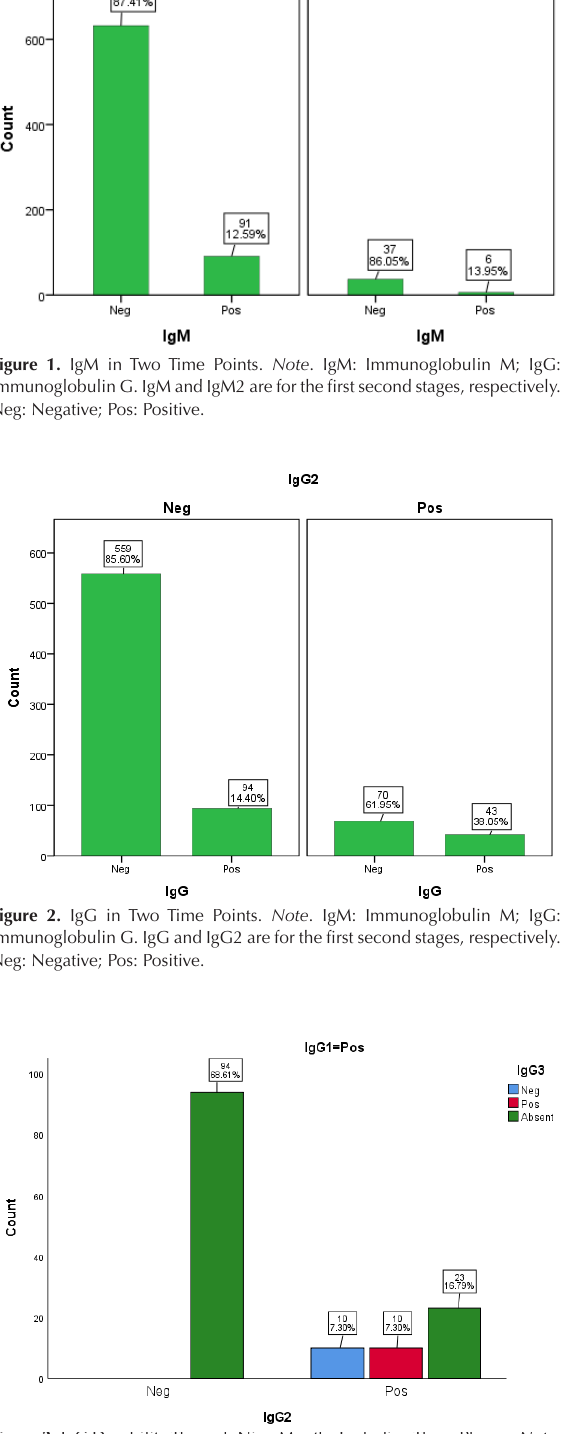
Figure 3. IgG Durability Through Nine Months Including Three Phases. Note . IgG: Immunoglobulin G; Neg: Negative; Pos: Positive.